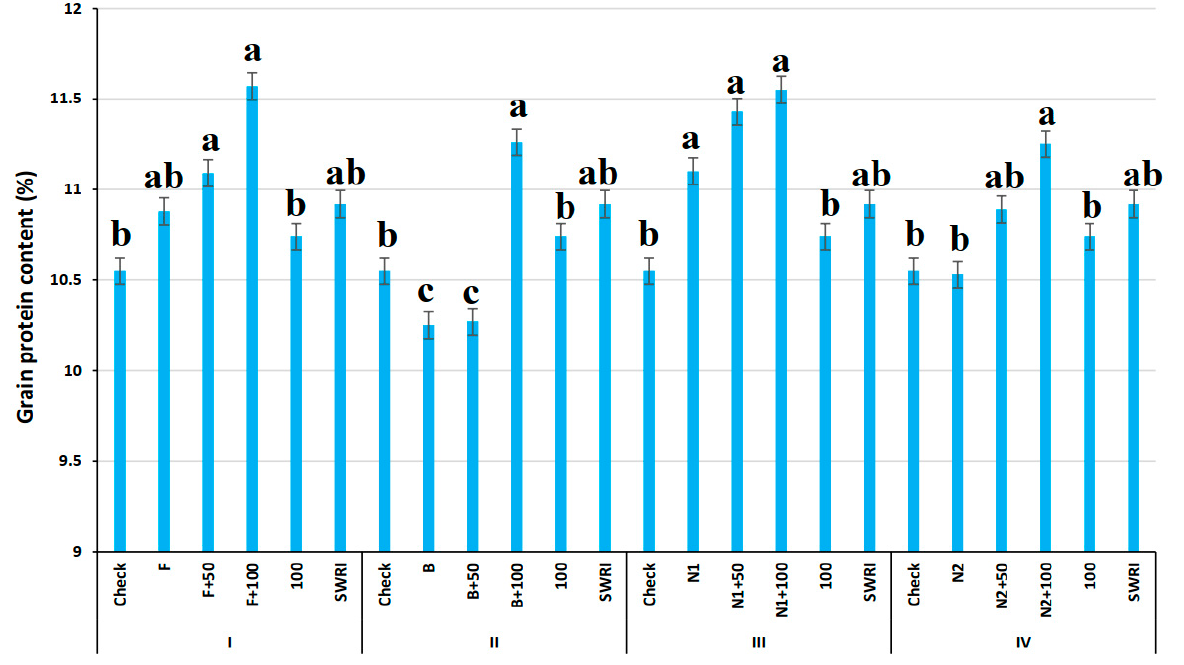
Figure 3. Changing trend of the grain protein content of the Azar-2 rainfed wheat cultivar under the effects of different applied biofertilizers and their combinations with N, P, and Zn soil test need-based chemical fertilizers (I = F, F + 50% ST, F + 100% ST, 100% ST, and SWRI; II = B, B + 50% ST, B + 100% ST, 100% ST, and SWRI; III = N1, N1 + 50% ST, N1 + 100% ST, 100% ST, and SWRI; IV = N2, N2 + 50% ST, N2 + 100% ST, 100% ST, and SWRI). Means followed by the same letters within columns are not significantly different at the 5% level.